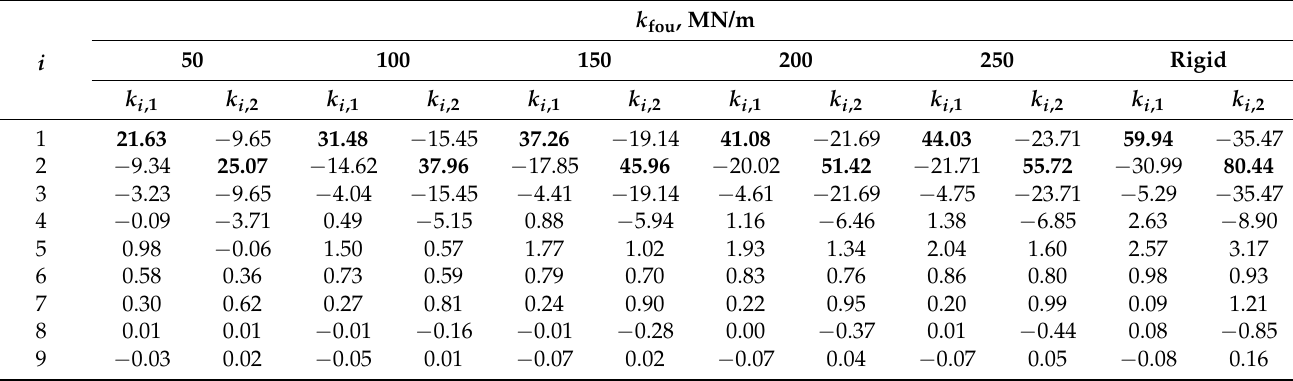
Table A6. Values k i , j of stiffness matrix k expressed in MN/m, for n = 16 and k fou = 50, 100, 150, 200, 250 MN/m and k fou - rigid (elements k j,j ( i = j ) are given in bold).